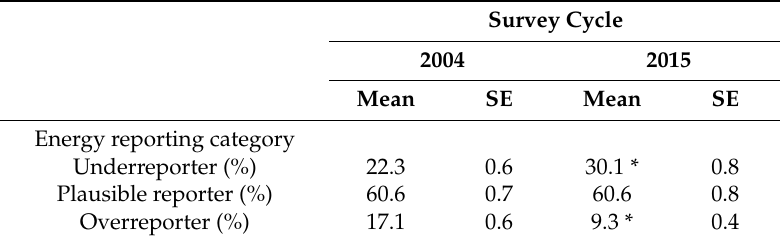
Table 2. Energy reporting characteristics among Canadians aged 2 years and older in 2004 and in 2015 ( n = 20,738 in 2004 and n = 13,611 in